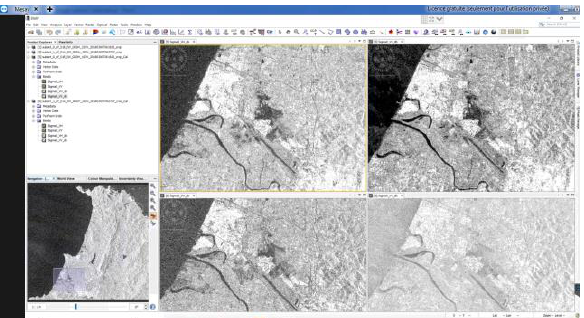
Figure 3. Results of using S1 SAR data. Two stacks are radiometrically calibrated.